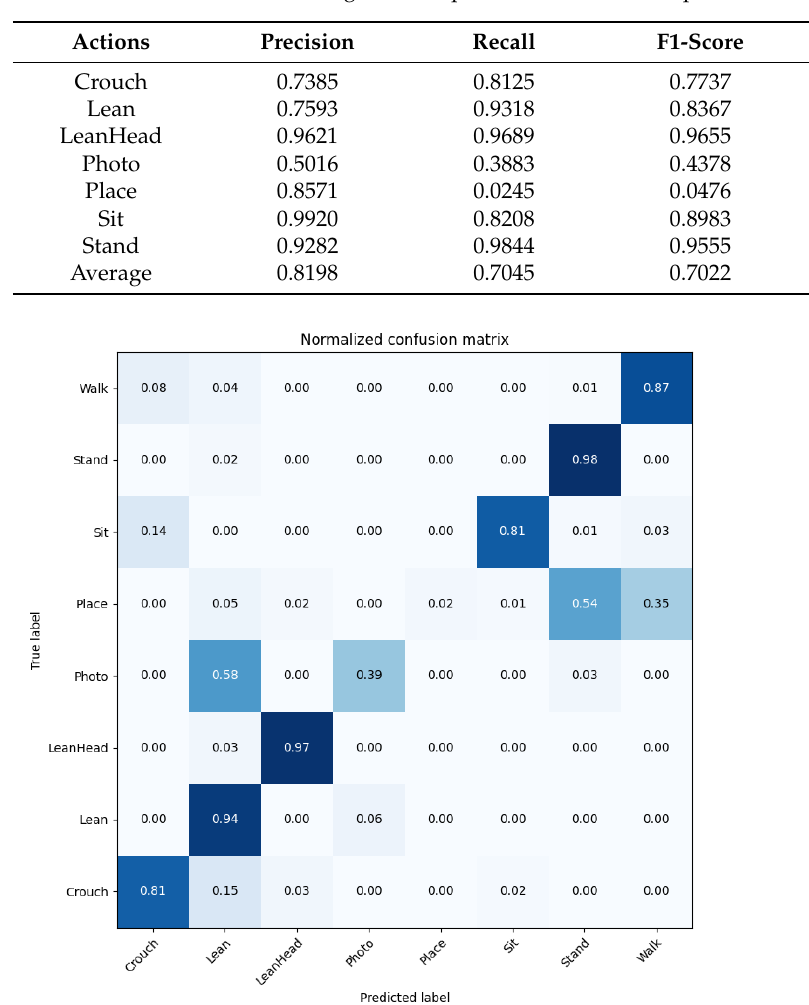
Table 6. Evaluation of action recognition on private CCTV dataset-split1.